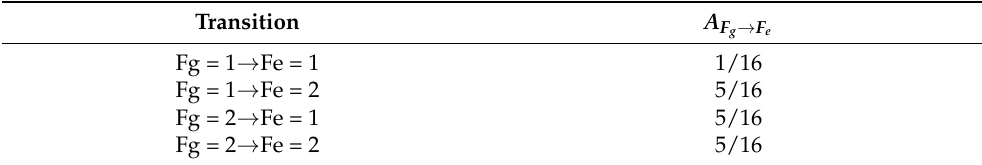
Table 1. Relative strengths A F of the individual D1 hyperfine resonances for photon absorption. g → F e Transition